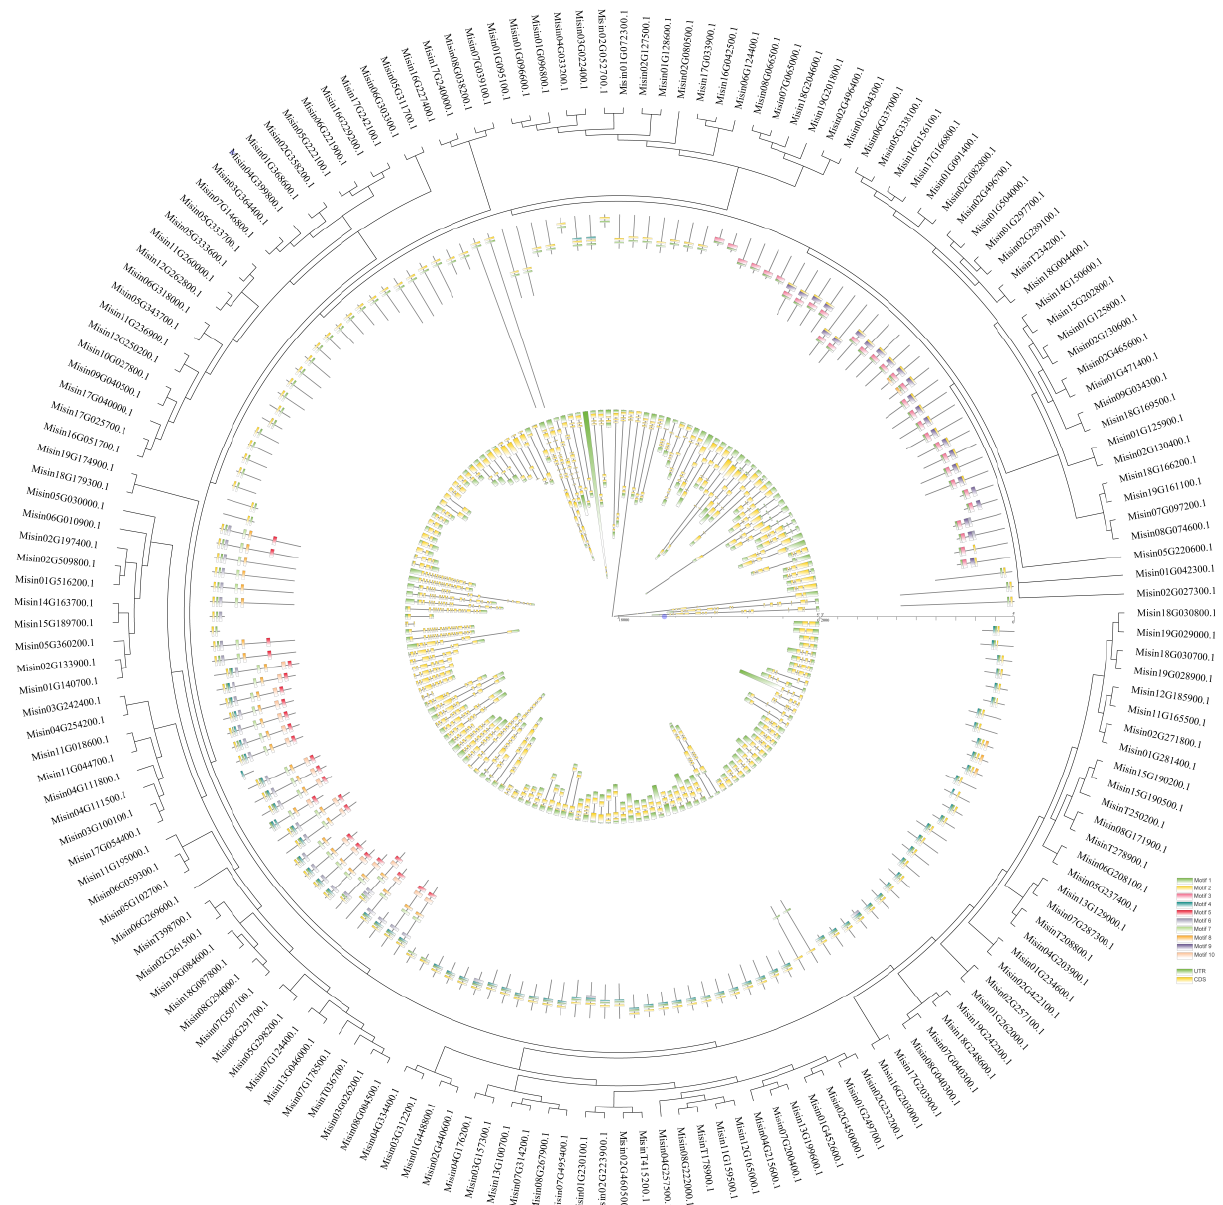
Figure 2. A phylogenetic analysis of M. sinensis HD-Zip genes, as well as the pattern of motifs and gene structure. By using MEME, the HD-Zip proteins ’ motifs composition was identified, and gray lines indicate non-conserved sequences. An overview of the sequence information for 10 motifs can be found in Figure S1. With the online tool GSDS, the exon-intron structure of M. sinensis HD-Zip genes was analyzed. The lengths of exons and introns were proportionately displayed.